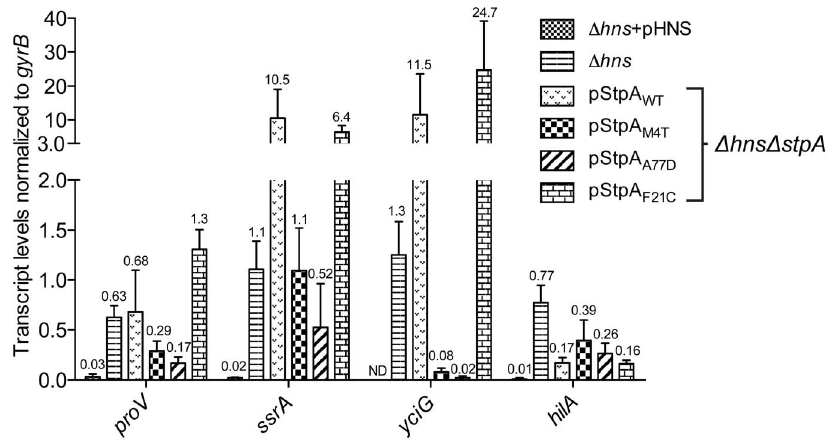
Figure 7. Point mutations A77D and M4T enhance StpA repression of select hns regulated loci. Transcript levels of four H-NS regulated genes, proV , ssrA , yciG and hilA , were measured by reverse transcriptase QPCR in a D hns/ D stpA strain expressing StpA WT or the variants StpA M4T , StpA A77D and StpA F21C . Transcript levels were also assayed in D hns and D hns complemented backgrounds ( D hns + pHNS).